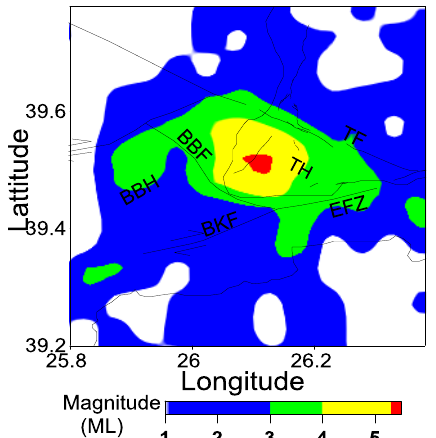
Figure 3. Spatial distributional pattern of mainshock-aftershock magnitudes (ML) (Contours show magnitudes).